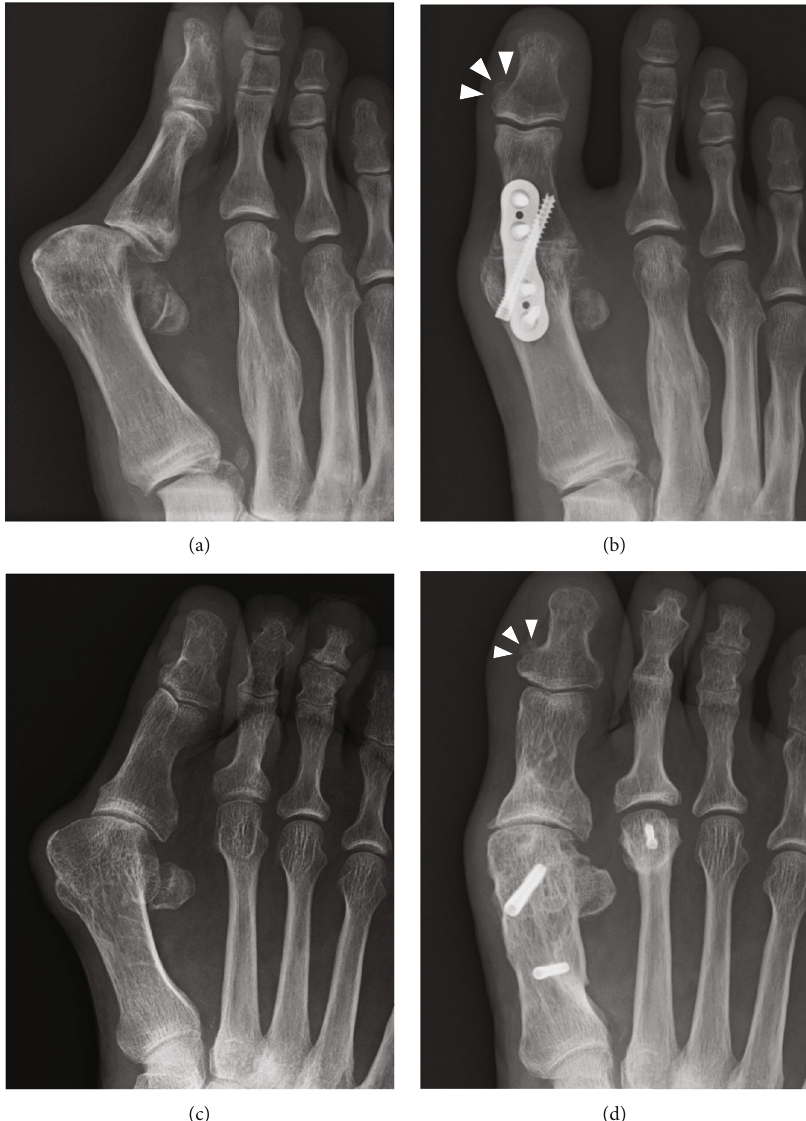
Figure 1: Representative anteroposterior foot radiographs of the cases showing increased width of medial bone excrescence at the distal phalanx of the hallux after the metatarsophalangeal arthrodesis (a, b) or metatarsal osteotomy (c, d) performed to rectify hallux valgus deformity. Arrowheads indicate the protruded bone excrescence after the